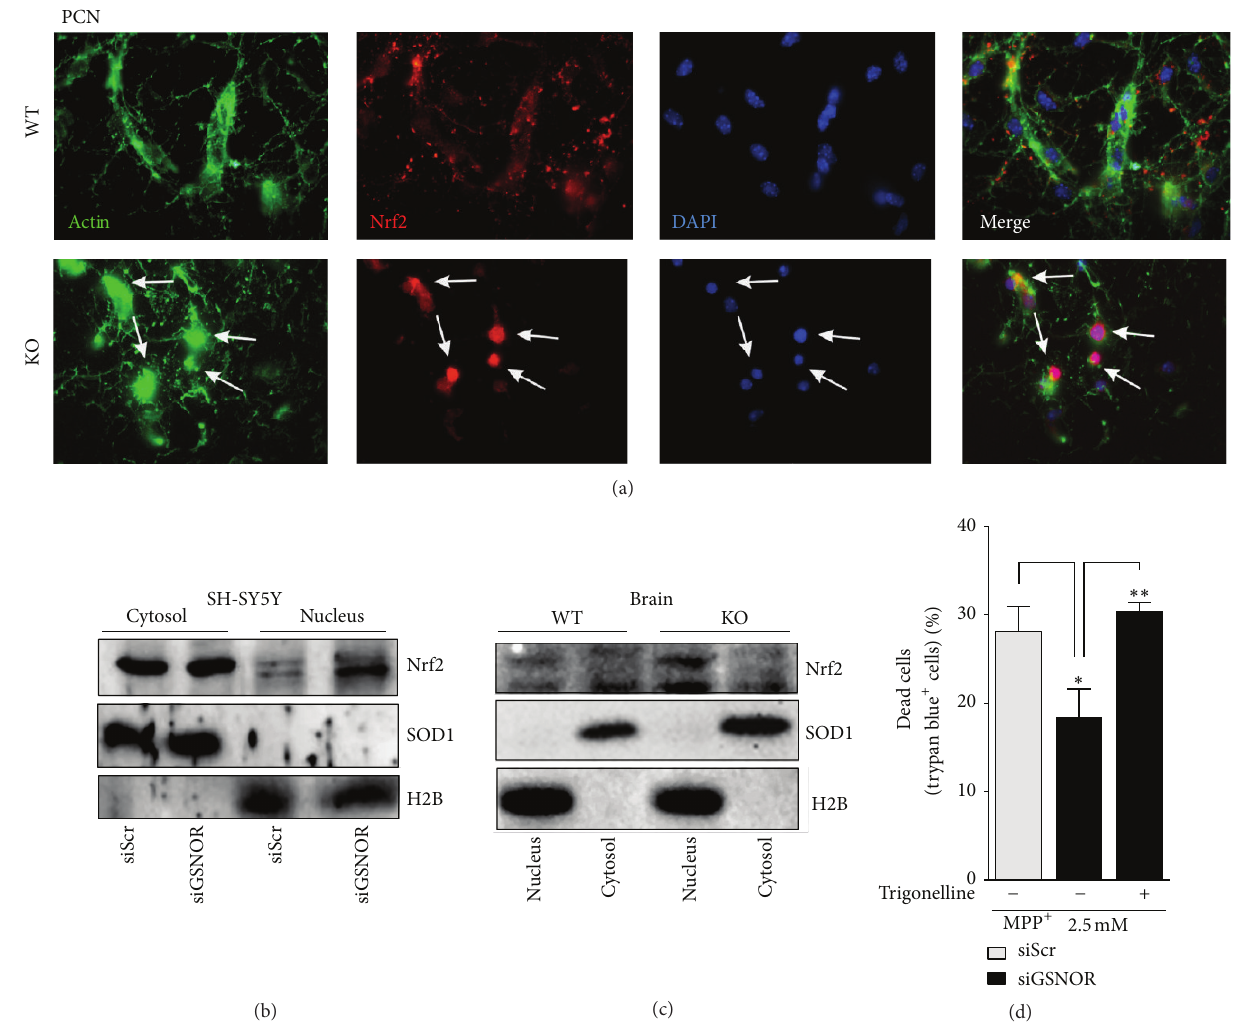
Figure 5: Nuclear localization of Nrf2 in GSNOR-downregulating systems. (a) Fluorescence microscopy analyses of WT and GSNOR-KO PCN upon staining with anti-Nrf2 antibody (red), phalloidin (green), and Hoechst 33342 (blue), with the last two probes used to selectively highlight actin (cytoskeleton) and nuclei, respectively. Western blot analyses of Nrf2 in nuclear and cytosolic fractions obtained from (b) siScr and siGSNOR SH-SY5Y cells or (c) GSNOR-KO and WT brains. Western blots shown are representative of at least 𝑛 = 3 independent experiments that gave similar results. SOD1 and histone 2B (H2B) were selected as loading and purity controls of cytosol and nuclei, respectively. (d) Direct cell count upon Trypan blue staining of siScr and siGSNOR SH-SY5Y cells treated for 24 h with 2.5 mM MPP + in the presence or absence of 1mM of the Nrf2 pharmacological inhibitor trigonelline. Graphs shown represent the mean of data ± SD of 𝑛 = 3 independent experiments, ∗ 𝑃 < 0.05 and ∗∗ 𝑃 < 0 .